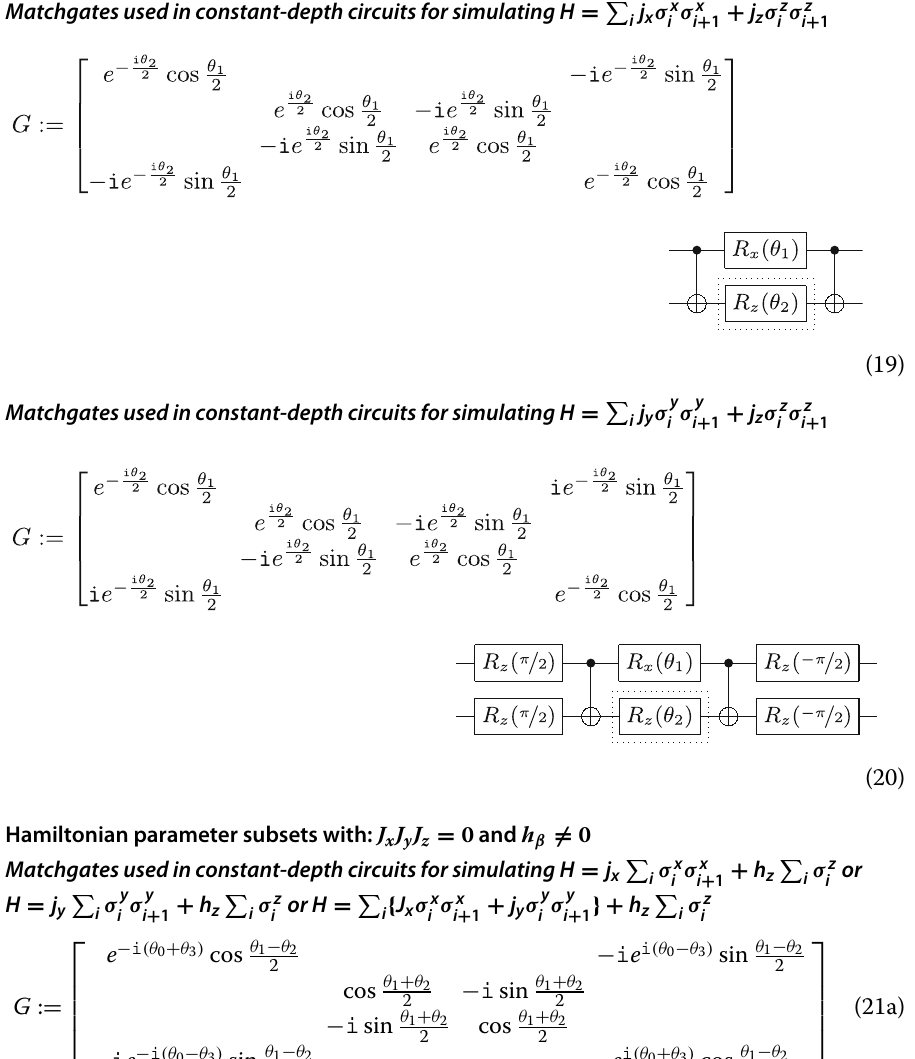
(cid:2) (cid:2) σ x σ x + h σ y y i i i i i + 1